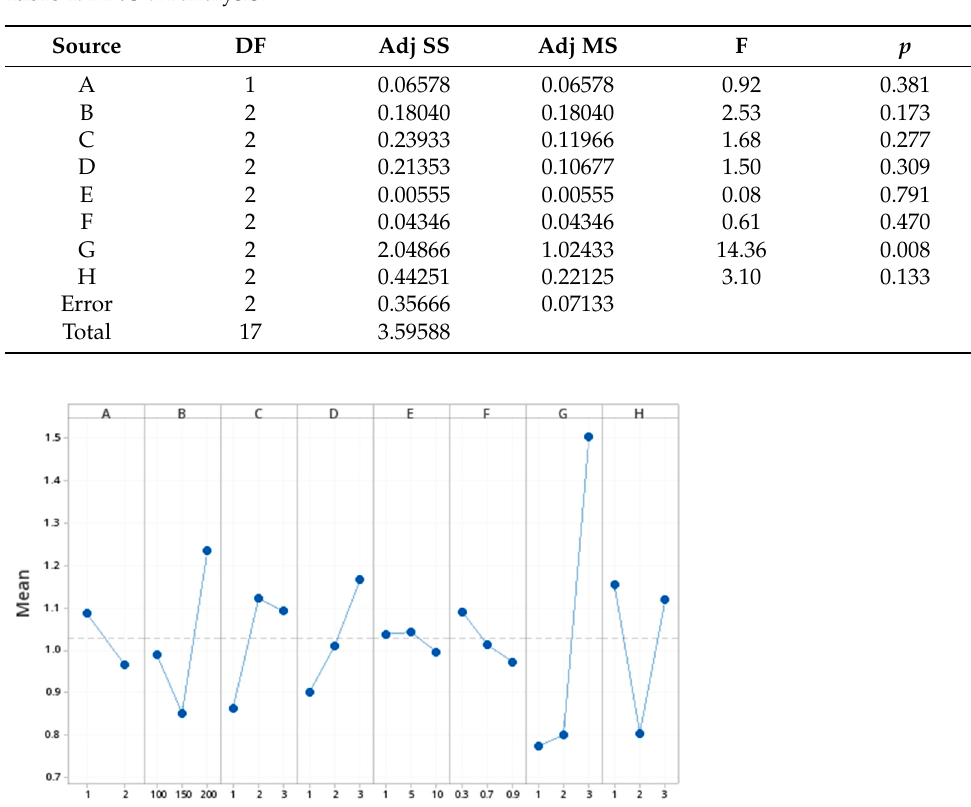
Figure 6. Main effects plot. Table 5. Selected solver option